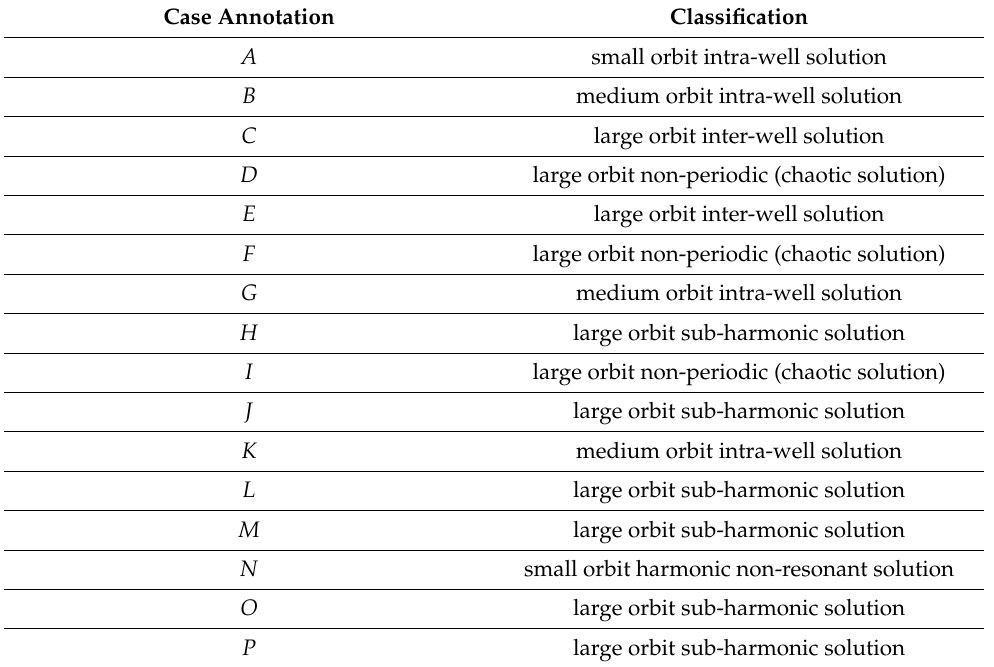
Table 1. Classification of cases A – P . Large orbits consistently have an inter-well oscillation character, while small and medium orbits are located in one of the potential wells (intra-well oscillations) and differ by the amplitude of